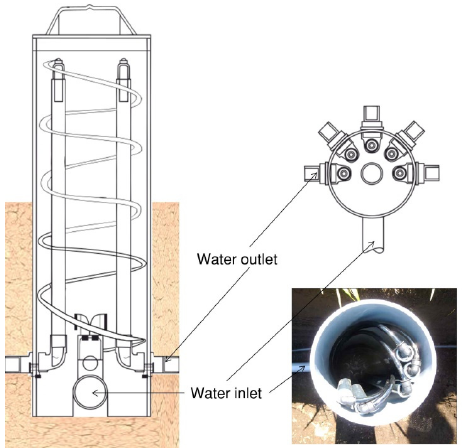
Figure 5. Schematic diagram of water distribution column of OPSIS.